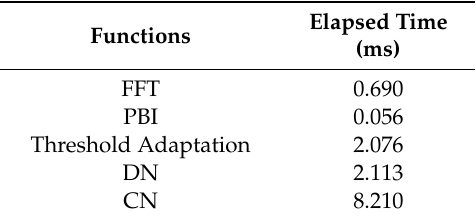
Table 7. Computational time for an